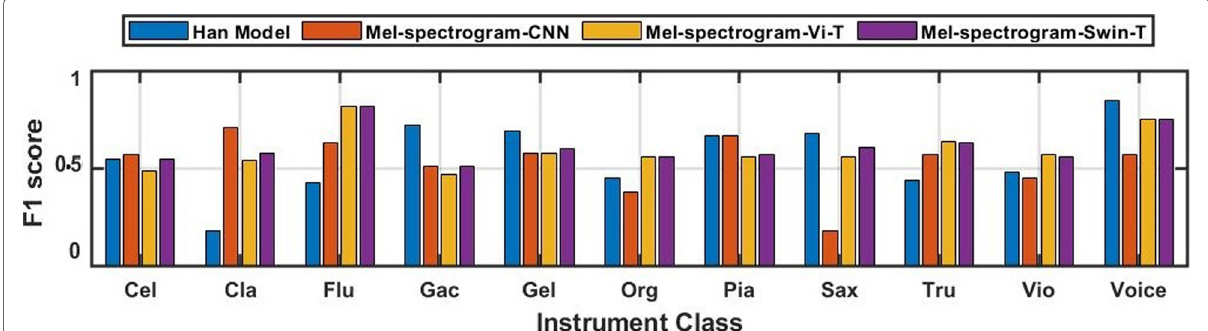
Fig. 5 Instrument-wise F1 scores for Mel-spectrogram experiments with data augmentation